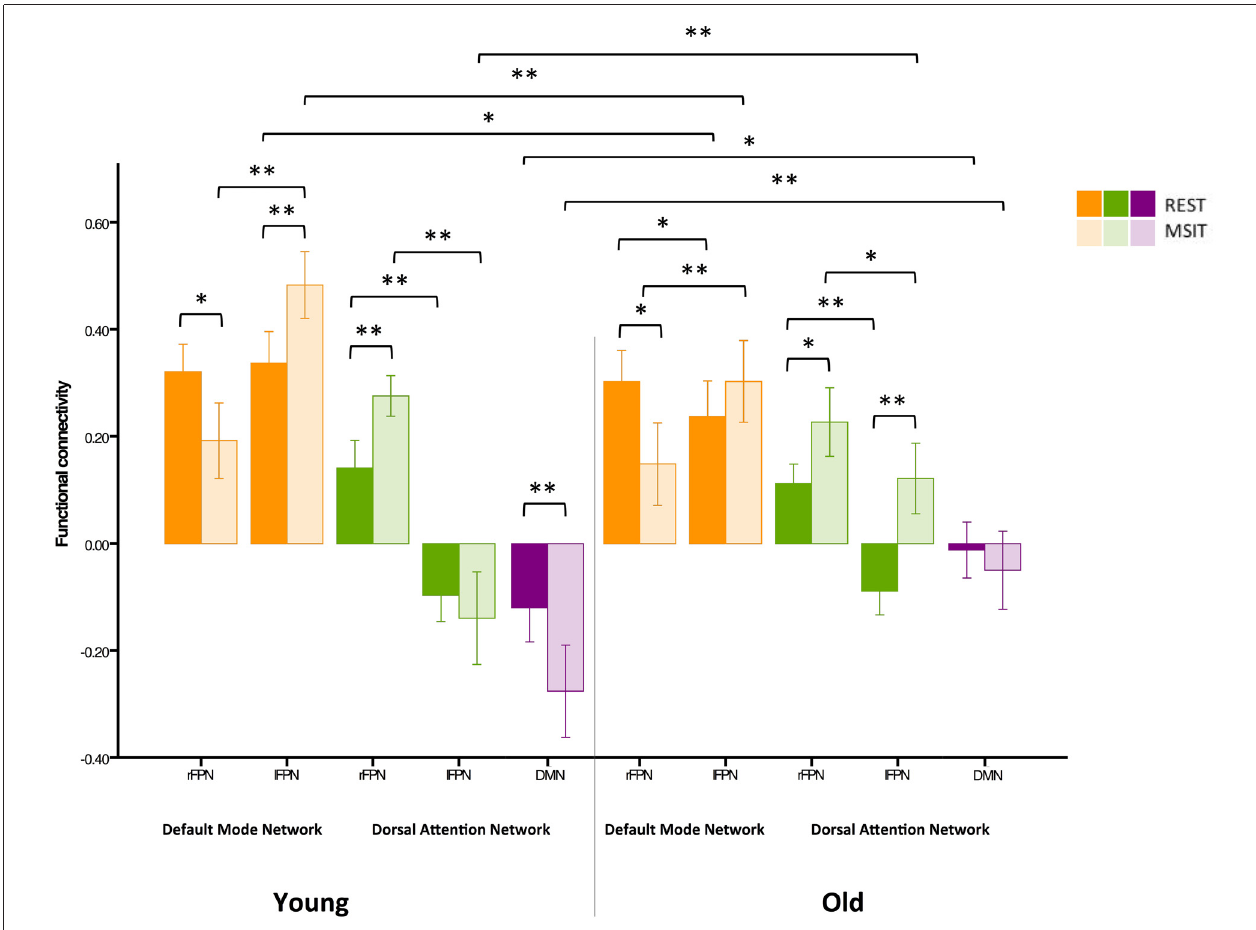
FIGURE 7 | Control analysis on functional connectivity levels among the DMN, FPN and DAN during rest and the MSIT for younger and older adults. Connectivity between the rFPN and DMN decreased for both groups from rest to task. The younger also had higher connectivity between the lFPN and DMN during the MSIT when compared to rest, whereas the old showed no connectivity differences between states. Importantly, there were no differences in rFPN-DMN connectivity between groups during both states, whereas connectivity between the lFPN and DMN was higher for young during both rest and task. Hence, despite exhibiting seemingly opposite effects, the same trend is still observed—an age-related difference that is present during one state is also present during the other and vice-versa. In line with our previous findings, both groups showed an increase in rFPN-DAN connectivity during the MSIT compared to rest, and there were no differences between groups. Young also showed negative connectivity between the lFPN and DAN, with no significant difference between rest and task, whereas the old group’s connectivity increased during the MSIT. This is also consistent with our previous results, where young and old similarly increased rFPN-DAN connectivity during the MSIT, but there were no age-related differences in either state. The same trends are also present for the lFPN and DAN, indicating that the young did not change their connectivity levels from one state to the other, whereas the older group did. Finally, both groups had negative connectivity between the DMN and DAN, but the young showed increased anticorrelation during the task while older subjects did not. Importantly, the correlation between DMN-DAN connectivity changes and MSIT performance remained after regressing out motion ( r = − 0.408, p = 0.003). ∗ p < 0.05; ∗∗ p <